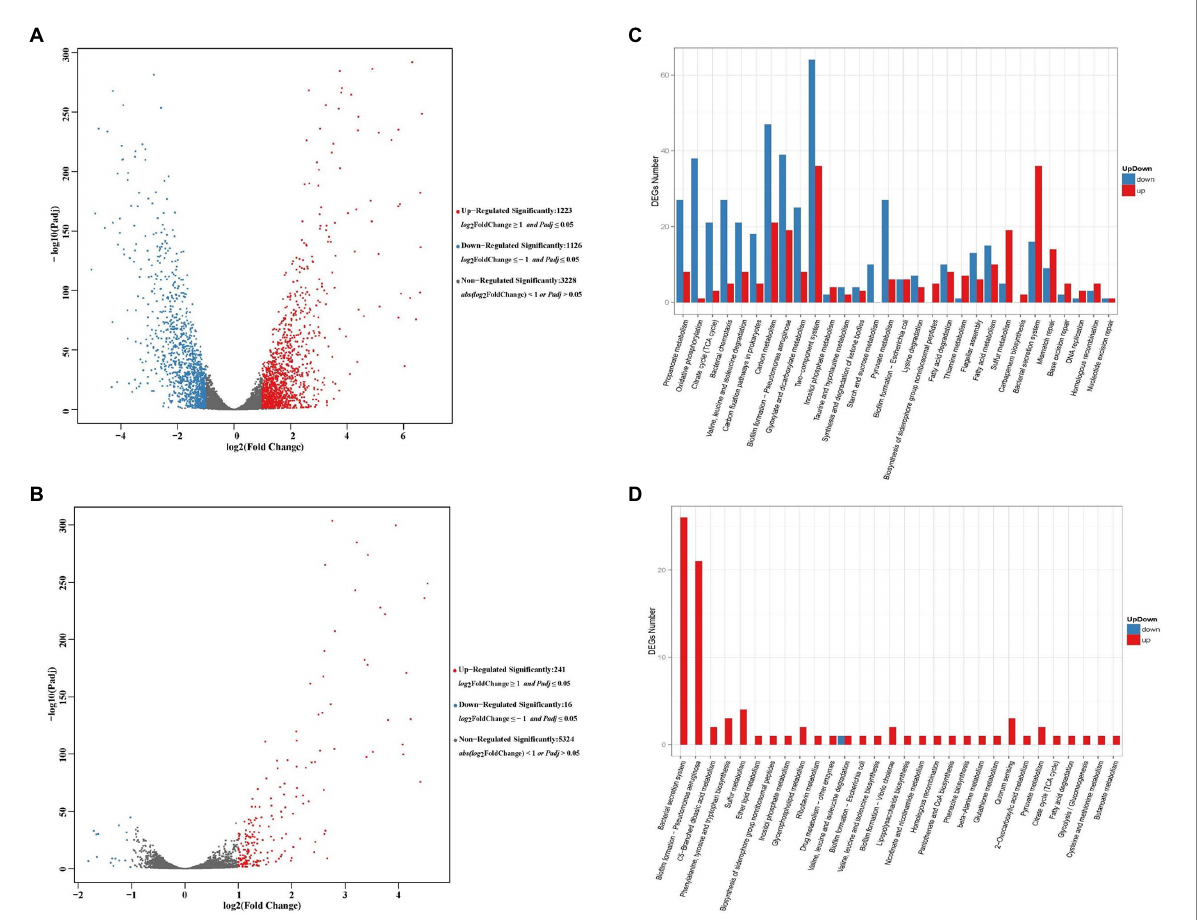
(Supplementary Figure S1F), biosynthesis of siderophore group nonribosomal peptides (Supplementary Figure S1G), and the bacterial secretion system (Supplementary Figure S1H) are shown in Supplementary Figure S1 in the Supplementary Material